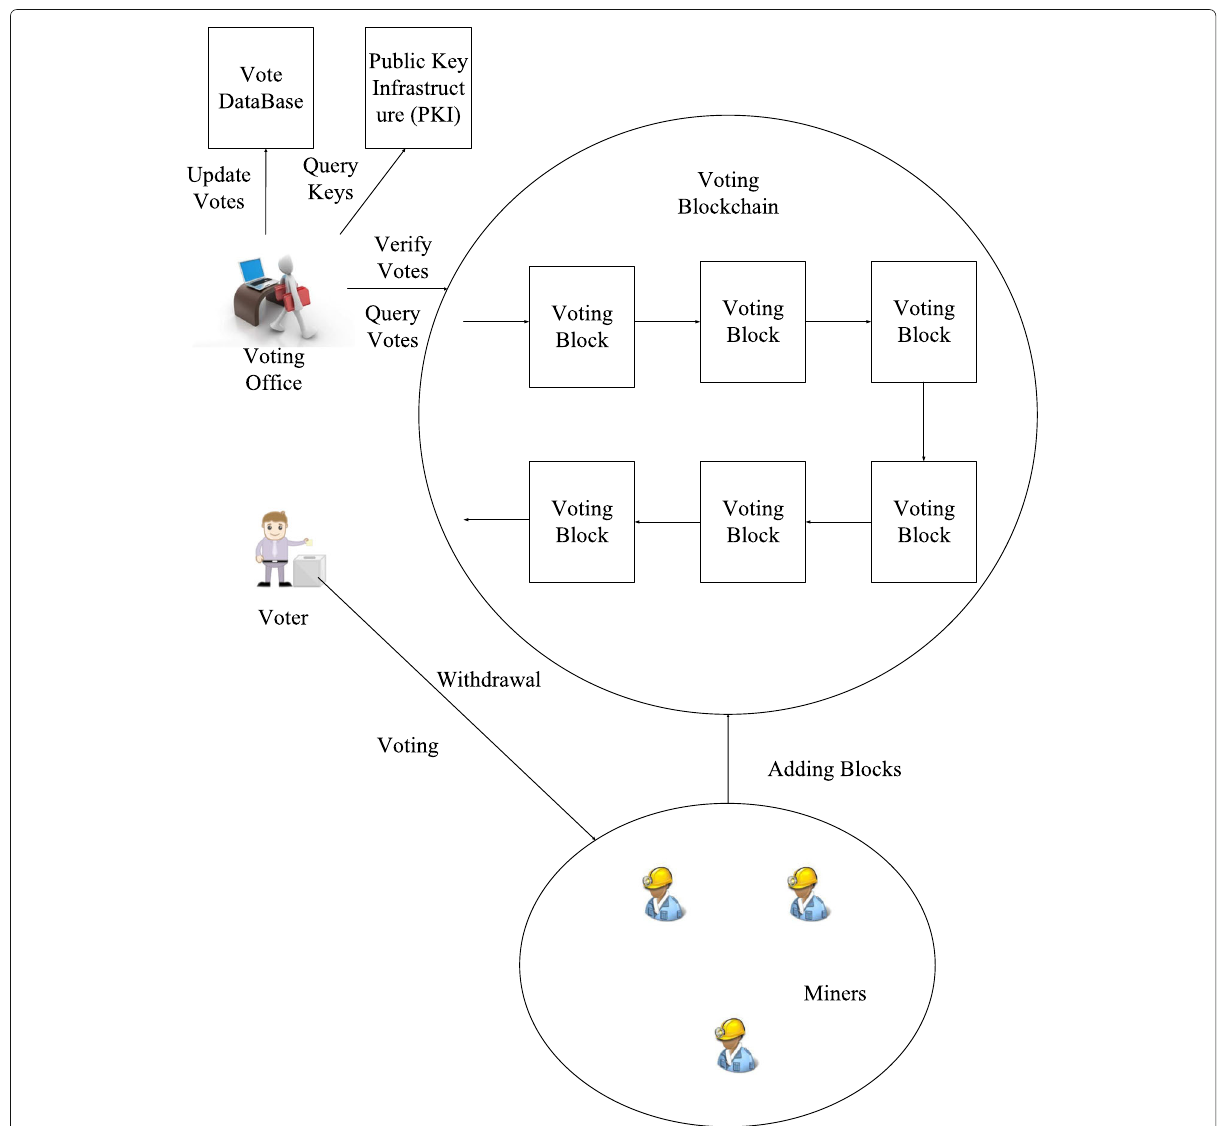
Fig. 1 Blockchain-based e-voting